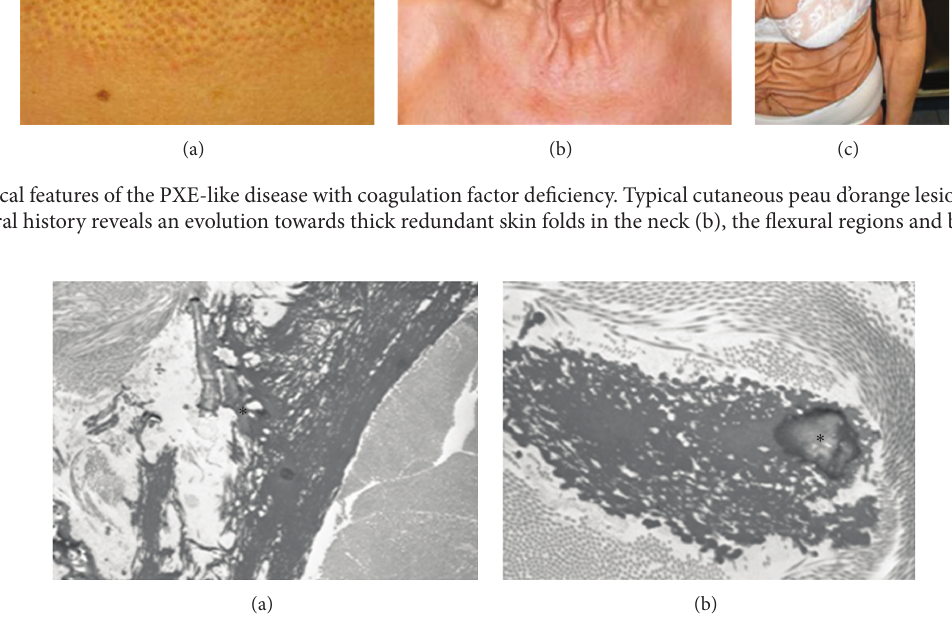
F 7: E� �ndings in the PXE-like disease with coagulation factor de�ciency. e elastic �ber network displays a ragged aspect (a, asterisk), while mineralization can be observed at the periphery of affected elastic �bers (b,